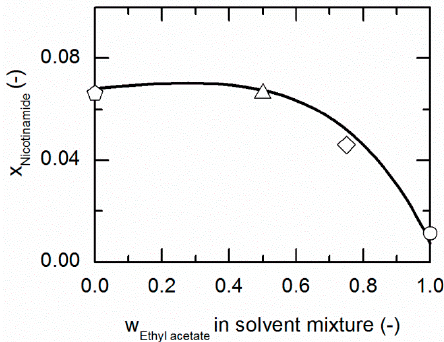
Figure 5. Solubility of nicotinamide (NA) in ethanol/ethyl acetate mixtures at 310.15 K. The line correspond to the PC-SAFT prediction; symbols represent the experimental data points for NA in ethanol (pentagon), in the ethanol/ethyl acetate (solute-free) mixtures 0.5/0.5 w / w (up-pointing triangle), 0.25/0.75 w / w (diamond) and in ethyl acetate (circle).